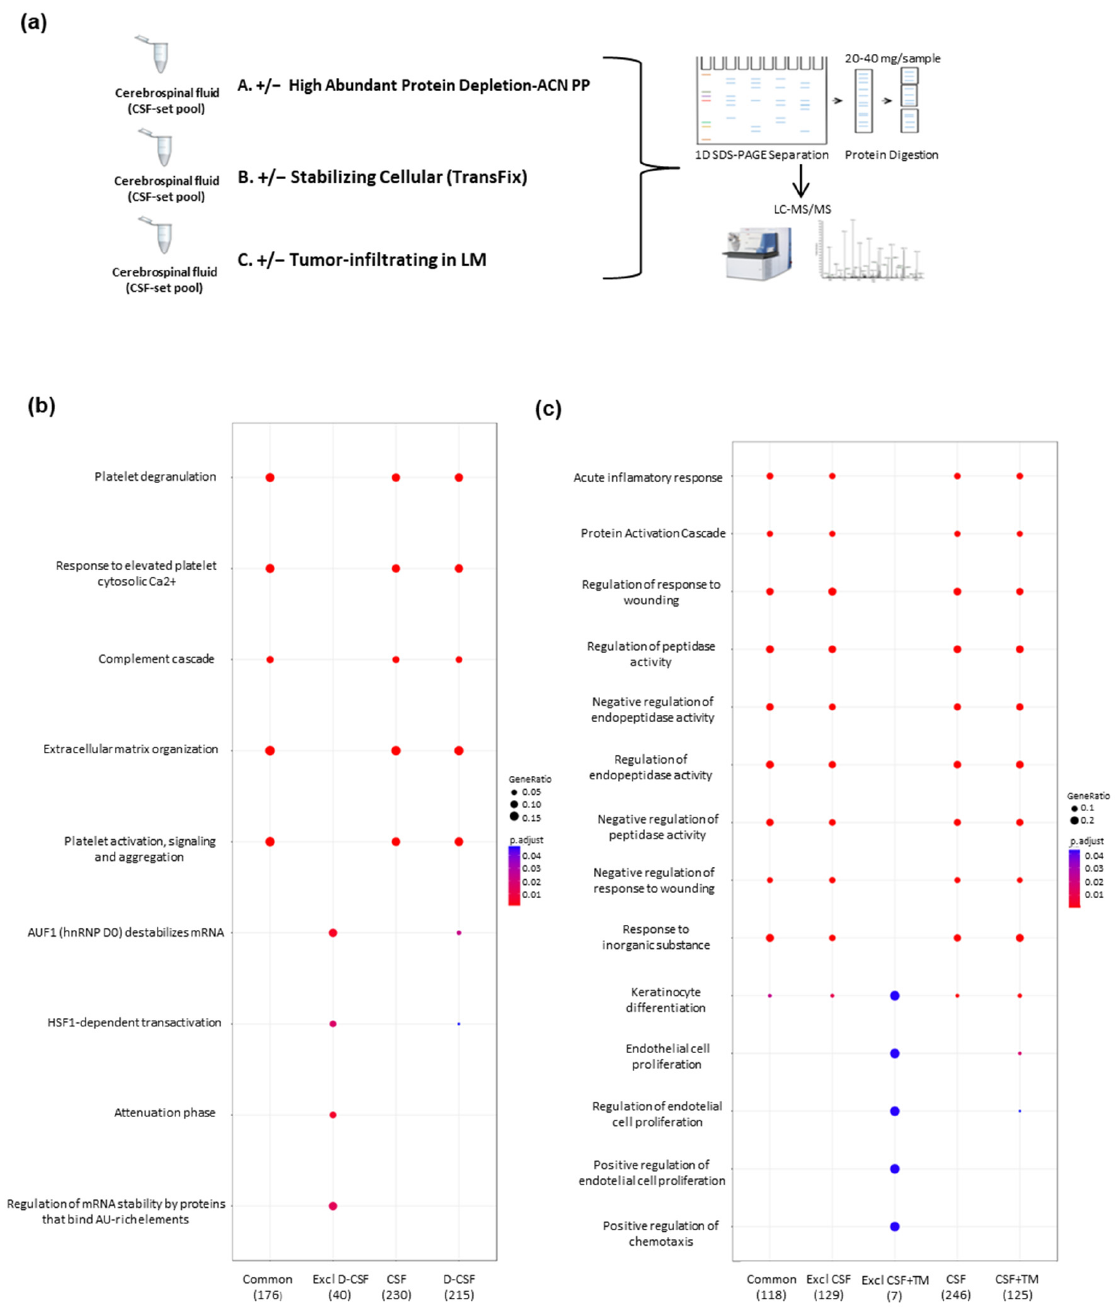
Figure 1. ( a ) The experimental workflow followed in the systematic characterization of CSF samples. ( b ) Plot of pathway analysis for the expressed proteins using the Reactome Pathway. This plot shows functional interactions for the detected proteins in each set of pooled samples (non-depleted, depleted, intersection and exclusive proteins of CSF-depleted). ( c ) Plot of different biological process of detected proteins using the GO functional enrichment analysis.